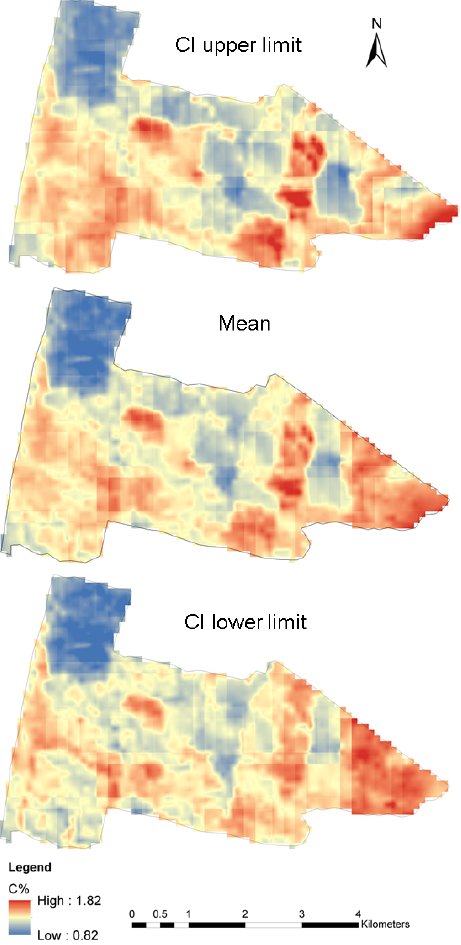
Figure 6. Bayesian ATPRK disaggregated map with 95% confi- dence